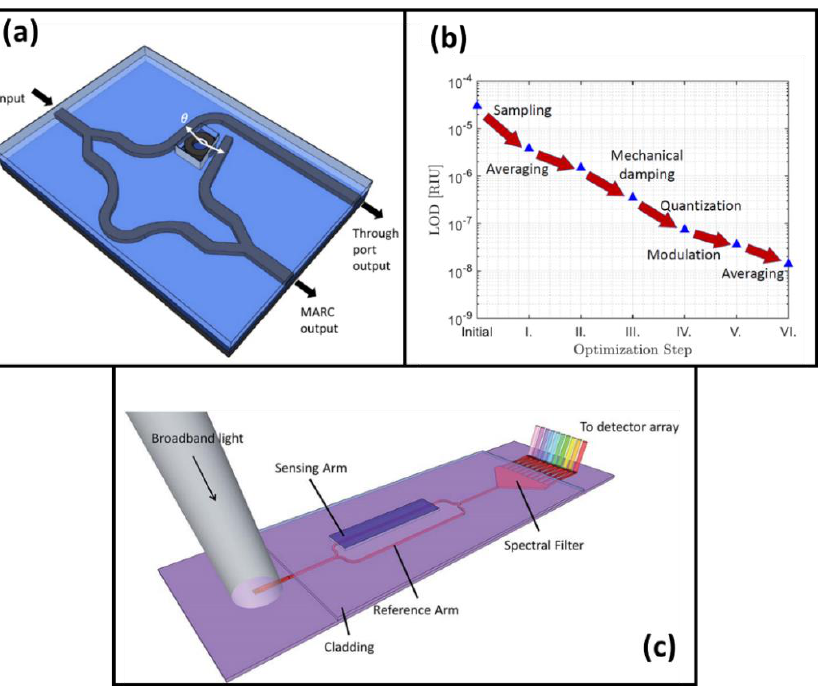
Figure 2. Improving sensitivity for interferometric sensors. ( a ) Scheme for the integration of a ring resonator in one arm of MZI. ( b ) Measured limit of detection of an integrated waveguide-based sensing system as different noise sources is addressed. ( c ) Scheme of an MZI sensor with an on-chip spectral filter integrated for linear readout. ( a ) Reprinted with permission from ref. [33], copyright 2022, The Optical Society; ( b ) reprinted with permission from ref [35], copyright 2019, MDPI; ( c ) reprinted with permission from ref [40], copyright 2018, the Royal Society of Chemistry.